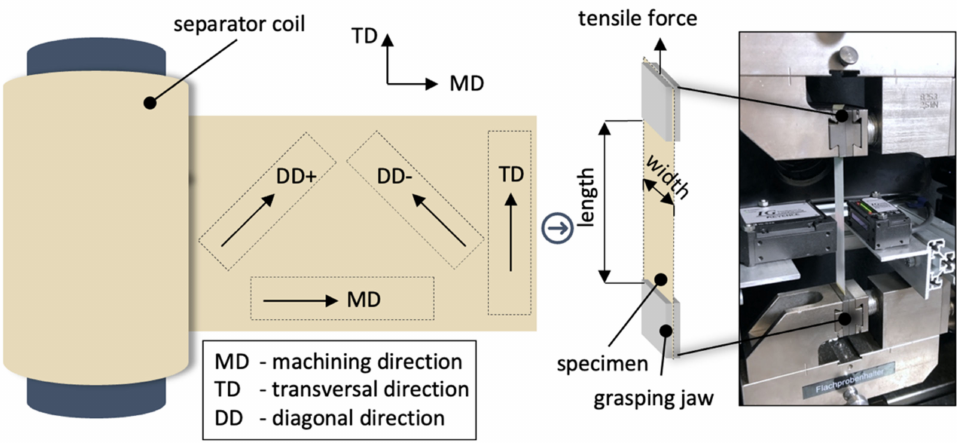
Figure 15. Shape, dimensions and cutout positions of the specimens; DD directions are rotated by 45 ◦ or 135 ◦ with respect to MD [8].